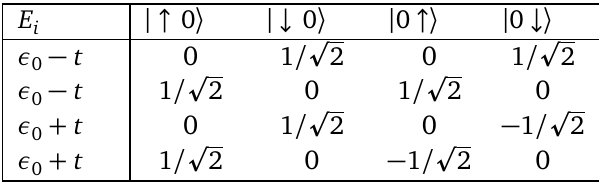
Table 1: Eigenvalues and coefficients of the symmetric Hubbard dimer for N = 1